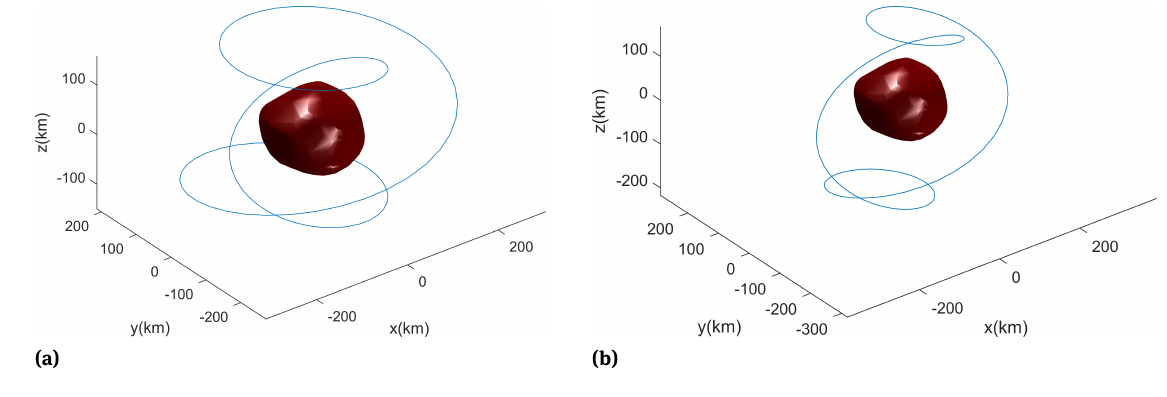
Figure 7. Two periodic orbits around the surface of 45 Eugenia. Table 4. Initial conditions of periodic orbits, here the length unit 232.409 km is the maxsize of 45 Eugenia, and the time unit 5.699 h is the rotational period of 45 Eugenia.